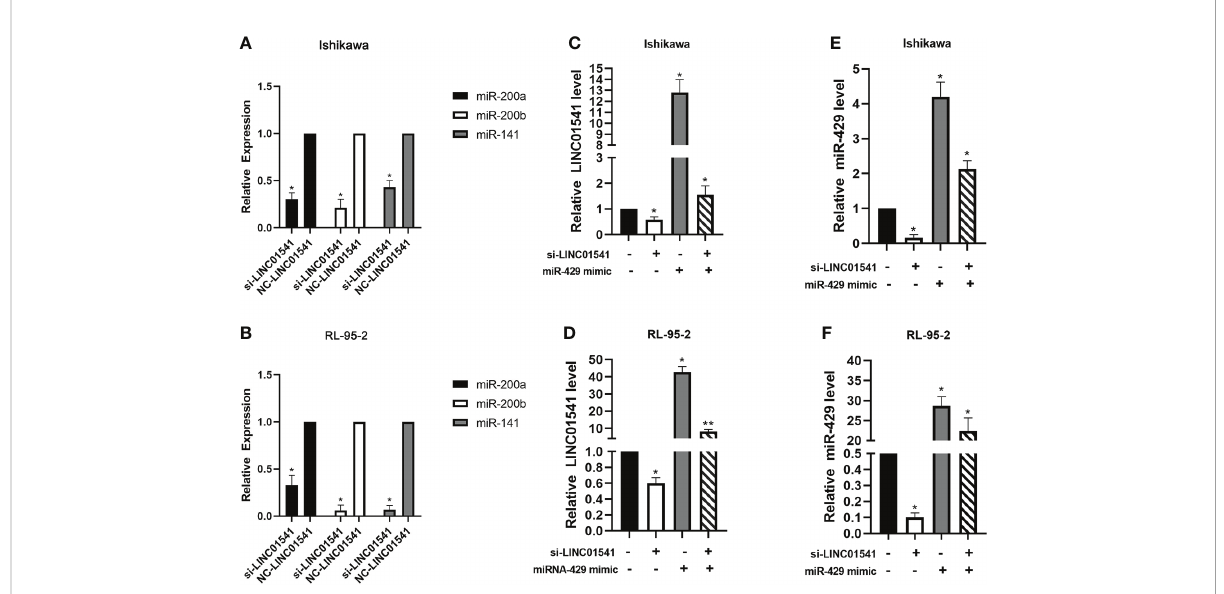
FIGURE 5 QRT-PCR was used to detect the expression of genes after LINC01541/miR-429 treatment. (A, B) Knockdown of LINC01541 was found to inhibit the expression of miR-200a, miR-200b, and miR-141 in Ishikawa and RL95-2 cells. (C – F) A co-culture system was constructed with LINC01541 siRNA and miR-429 mimic, and qRT-PCR was used to further verify the relationship between LINC01541 and miR-429 in Ishikawa and RL95-2 cells. (* P <0.05; ** P <0.01).